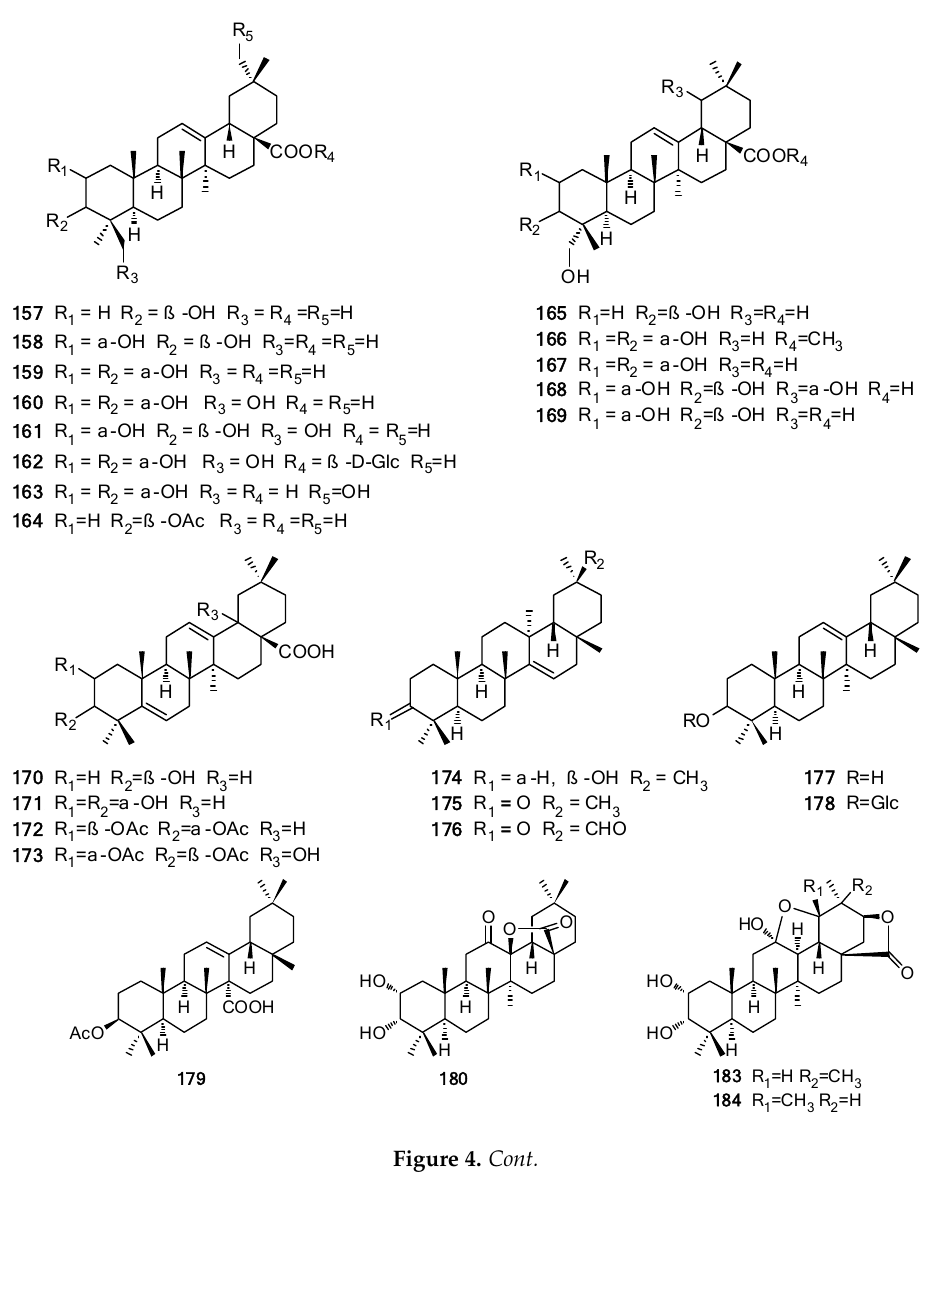
Figure 4 . Cont. Figure 4.